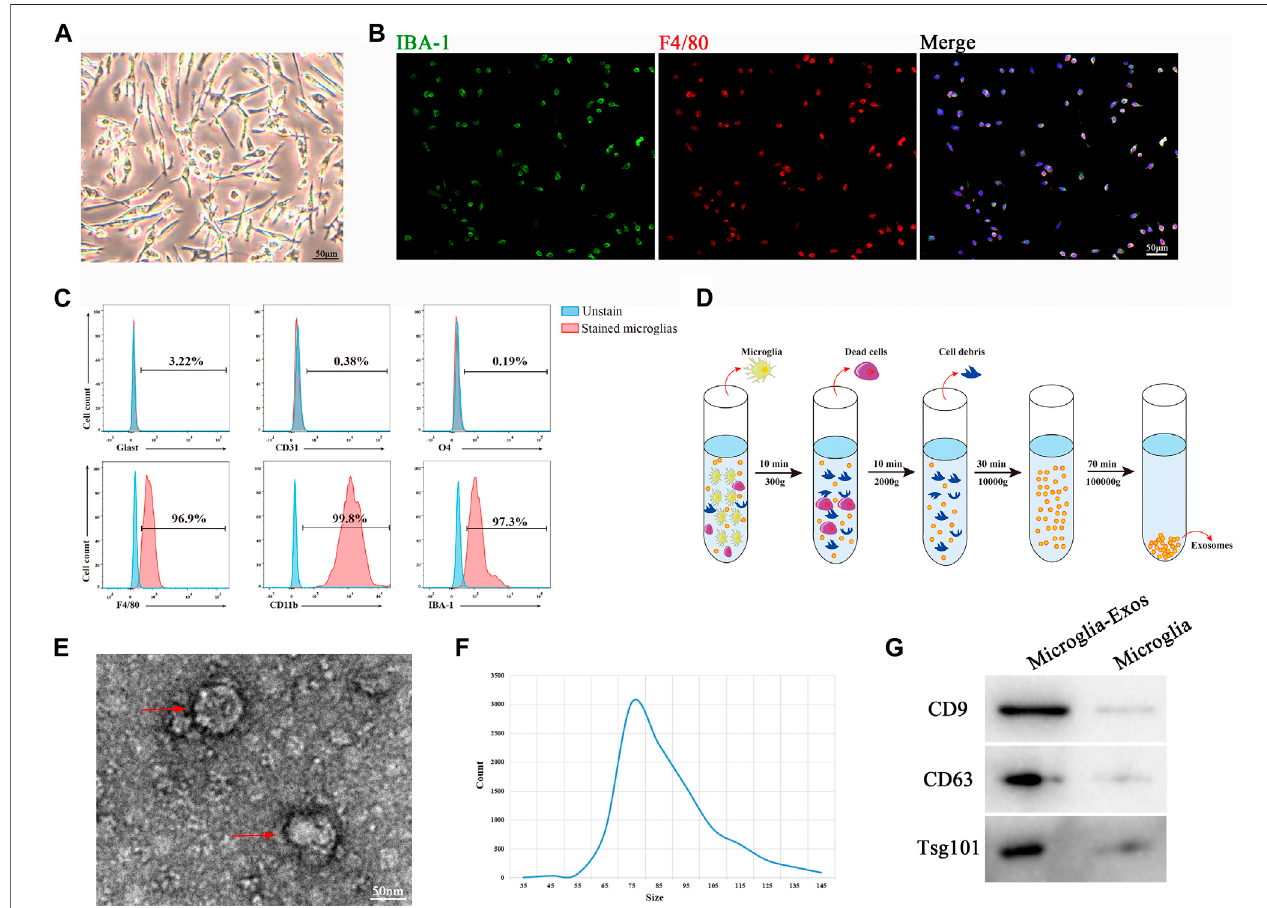
FIGURE 1| Morphology and characterizationofmicroglia cells and microglia-Exos. (A) Representative microscopic image ofmicroglia cells. Scale bar: 50 μ m. (B) Representative fl uorescent images of microglia cells staining with Iba-1 (green) and F4/80 (red). Scale bar: 50 μ m. (C) Flow cytometry analysis of microglia-positive markersF4/80,CD11b,andIBA-1and-negativemarkersGlast,CD31,andO4. (D) Schematicdepictionofsuper-centrifugationusedtoisolateandpurifyexosomes. (E) Transmissionelectronmicroscopy(TEM)imageofmicrogliacell – derivedexosomes.Scalebar:50 nm. (F) Nanotrackinganalysis(NTA)showedthatthediameterof microglia-derived exosomes ranged from 35 to 145 nm. (G) Western blot analysis of exosome markers CD9, CD63, and Tsg101.